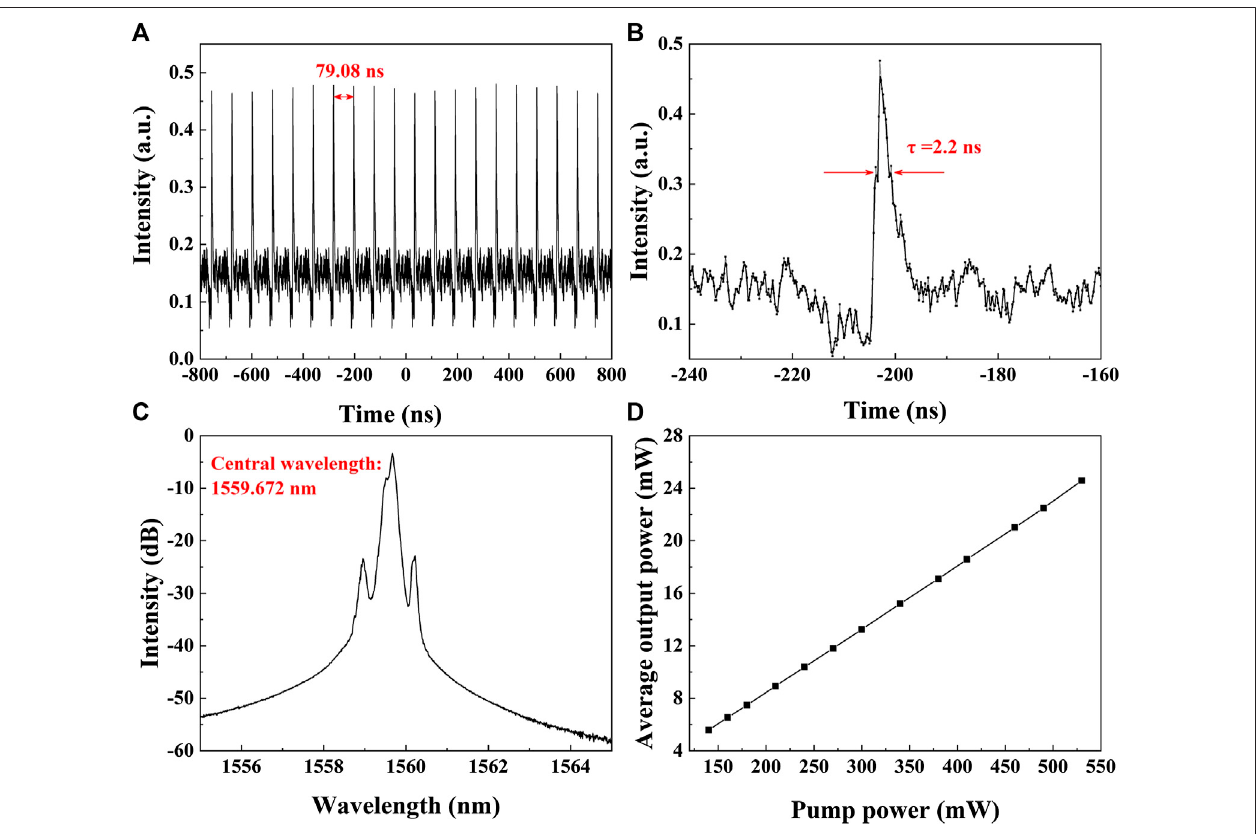
FIGURE 8 | Mode-locking performance: (A) Oscilloscope trace of the pulse train; (B) Oscilloscope trace of a single pulse; (C) Optical spectrum; (D) Output power versus pump power.